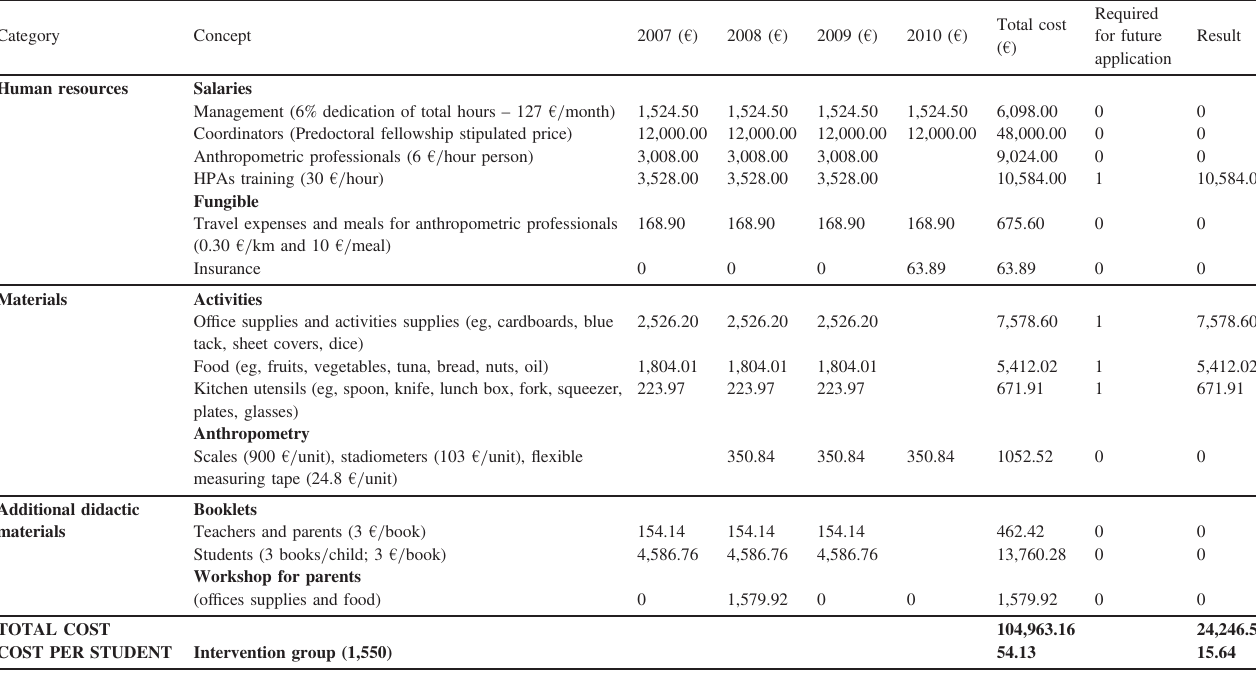
Table 1. EdA1 a program costs included in the cost-e ff ectiveness evaluation Category